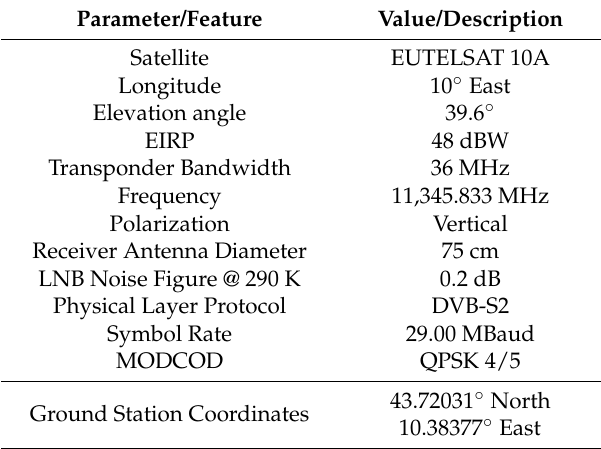
Table 4. Features of the satellite link used to test the rain sensing